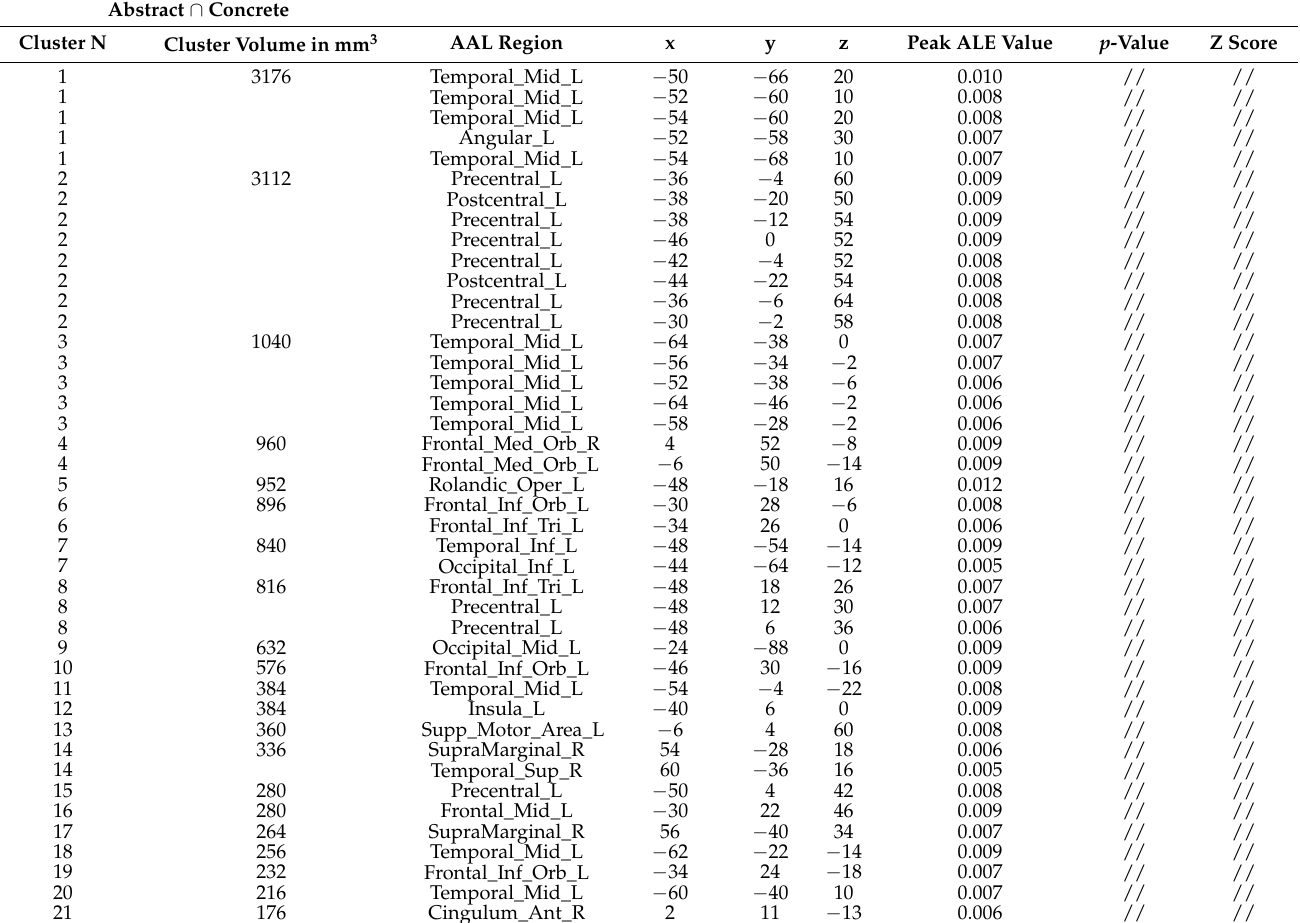
Table 2. Results for the conjunction analysis. Results are reported in Montreal Neurological Institute (MNI) space with anatomical labels from the Automated Anatomical Atlas (AAL). L = left; R =